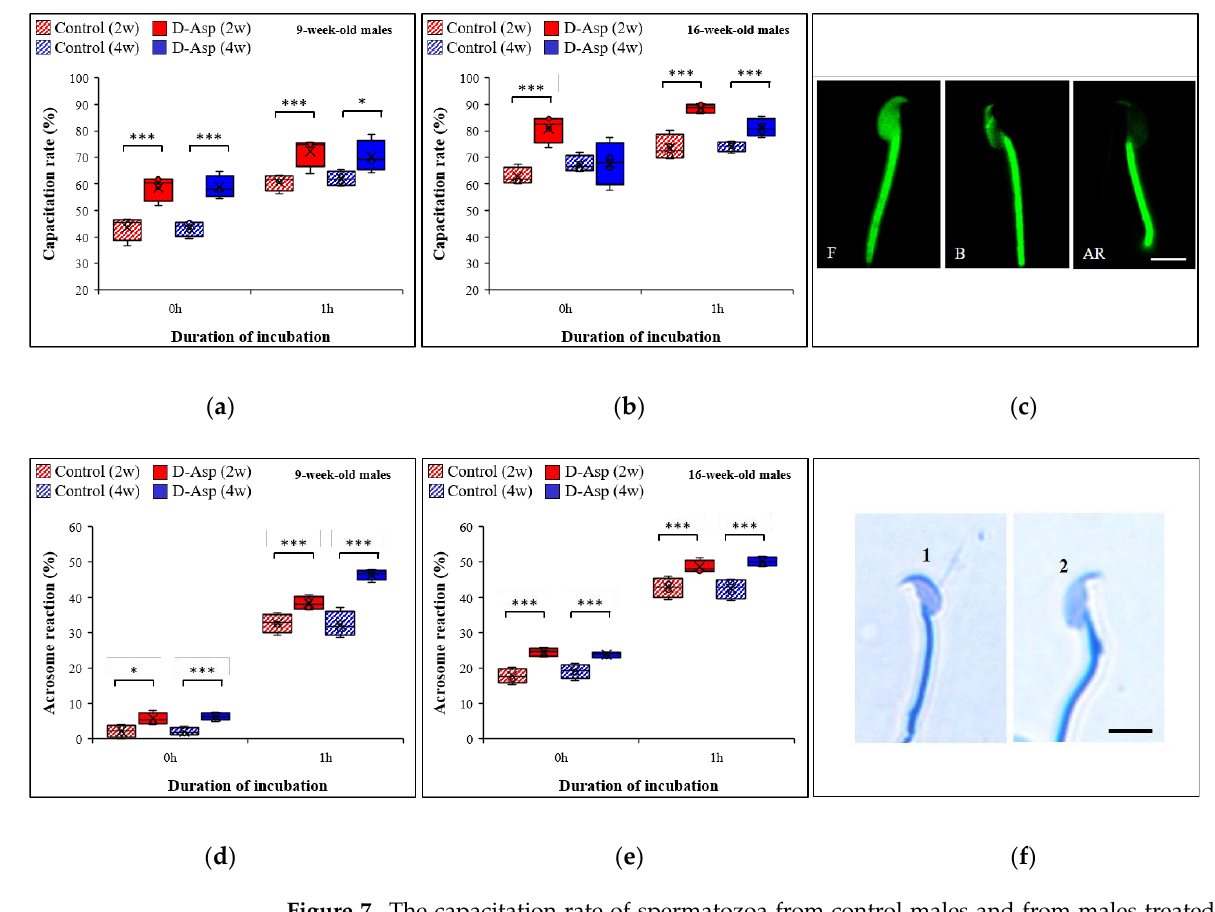
Figure 7. The capacitation rate of spermatozoa from control males and from males treated with D-Asp for 2 weeks or 4 weeks, which were either 9 weeks old ( a ) or 16 weeks old ( b ) at 0 h and 1 h. ( c ) Representative image of CTC staining: non-capacitated (F), capacitated (B), and acrosome-reacted (AR) spermatozoa. Scale bar = 3 µm. The acrosome reaction of spermatozoa from control males and from males treated with D-Asp for 2 weeks or 4 weeks at 0 h and 1 h. Males were either 9 weeks old ( d ) or 16 weeks old ( e ). ( f ) Representative image of Coomassie brilliant blue G-250 staining. (1) spermatozoa with acrosome, (2) spermatozoa without acrosome. Scale bar = 3 µm. Box-and-whiskers plot; data points: open circles, maximum: endpoint of upper whisker, minimum: endpoint of lower whisker, third quartile (75th percentile): upper edge of the box, first quartile (25th percentile): lower edge of the box, median (50th percentile): line inside the box, mean: X. Significant higher rates in D-Asp-treated males than in controls: *: p < 0.05, ***: p < 0.001.